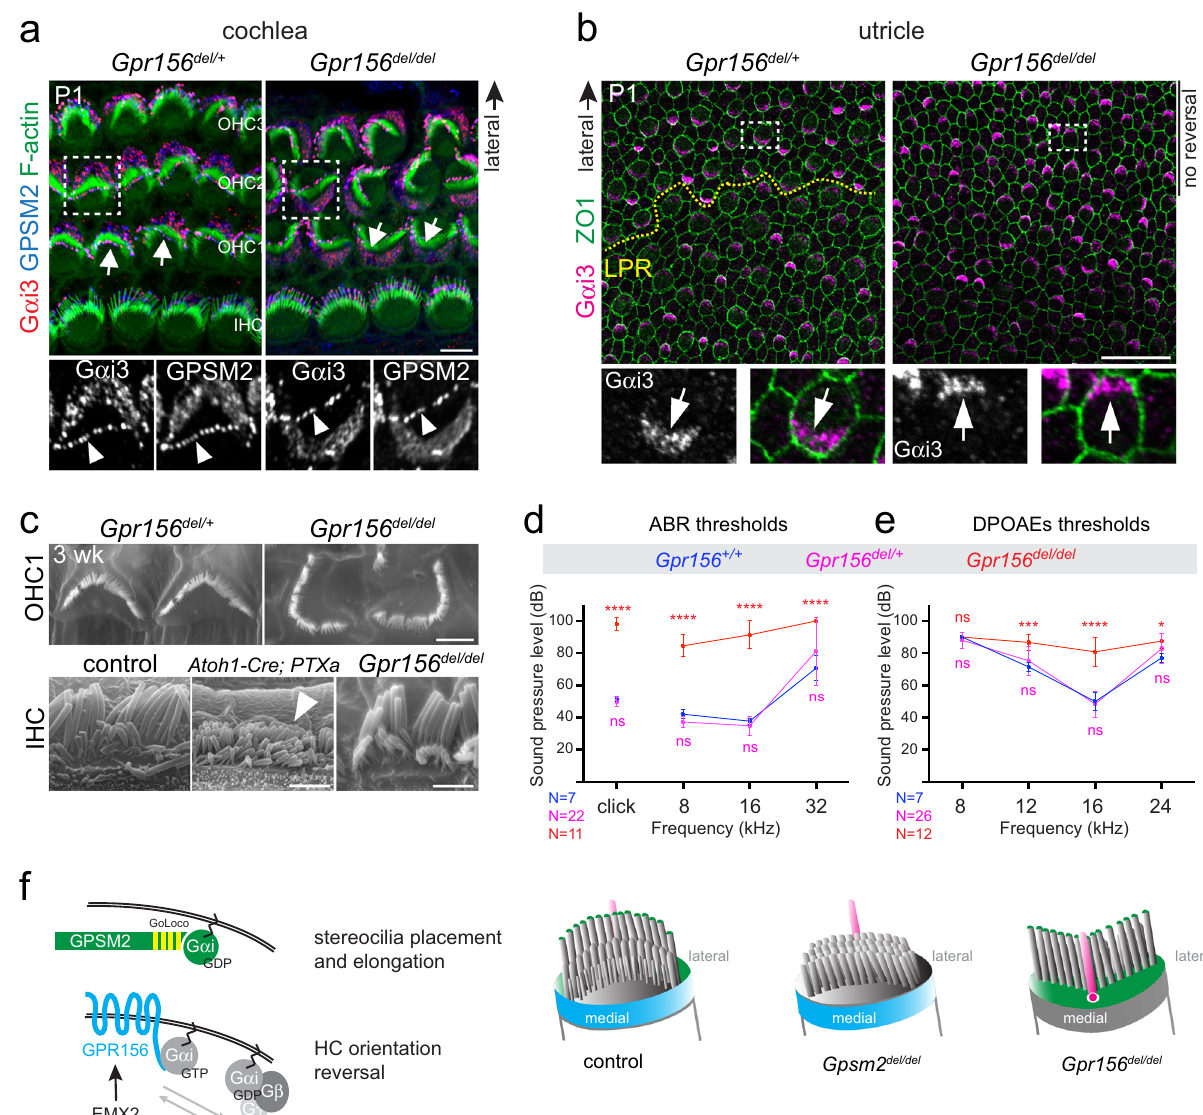
Fig. 7 GPR156-G α i and GPSM2-G α i are distinct functional modules in developing hair cells. a , b Normal apical enrichment of GPSM2-G α i3 ( a ) or G α i3 ( b ) in P1 Gpr156 mutant HCs in the cochlea ( a ) and utricle ( b ). Arrows indicate HC orientation. Note how GPSM2-G α i3 enrichment follows HC orientation when HCs are inverted (OHC1-2s in a ) or fail to reverse orientation (lateral HCs in b ). Bottom panels show a magni fi ed view of the HC boxed in the upper panels, and arrowheads point to GPSM2-G α i3 at stereocilia tips ( a ). See Supplementary Fig. 7a for saccule results. c Scanning electron microscopy views of OHC1s (top) and IHCs (bottom) at 3 week (wk). IHC stereocilia stunting is obvious in PTXa (arrowhead) but not Gpr156 mutants. See Supplementary Fig. 7b for larger fi eld views. d , e Auditory brainstem response (ABR, d ) and distortion product otoacoustic emissions (DPOAEs, e ) thresholds at ~4 week of age. X axis indicates broadband (click) and pure tone stimuli for ABR ( d ), or f2 for 2f1-f2 emission for DPOAEs ( e ). Y axis indicates the threshold of sound pressure level eliciting a response ( d ) or generating DPOAEs above noise fl oor ( e ) (mean ± SD; N indicates the number of animals tested per genotype; ABR click: Mann-Whitney test (two-tailed), **** p < 0.0001, ns p = 0.4943; ABR pure tones: two-way ANOVA with Sidak ’ s multiple comparisons, **** p < 0.0001, ns is p = 0.6928 (8 kHz), p = 0.9167 (16 kHz), p = 0.1061 (32 kHz); DPOAE: two-way ANOVA with Sidak ’ s multiple comparisons, Gpr156 + / + vs Gpr156 del/del : ns p > 0.9999, *** p = 0.0001, **** p < 0.0001; * p = 0.0138; Gpr156 + / + vs Gpr156 del/ + : ns is p = 0.9103 (8 KHz), p = 0.6116 (12 kHz), p = 0.9512 (16 kHz), p = 0.299 (24 kHz)). f Working model. GPSM2-G α i(GDP) (green) instructs stereocilia placement and elongation. In contrast, GPR156- G α i(GTP) (blue) triggers HC orientation reversal downstream of EMX2. Scale bars are 5 µ m ( a ), 20 µ m ( b ), 2 µ m ( c ).